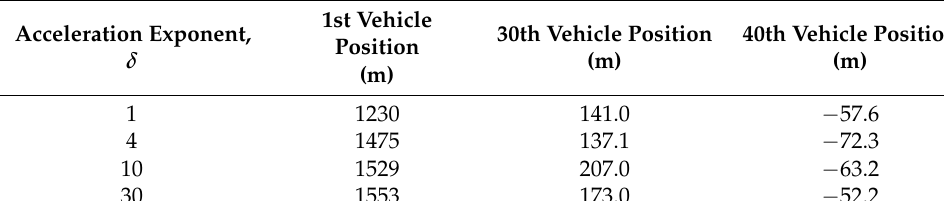
Table 7. Position of the 1st, 30th, and 40th vehicles at 60 s for the ID model.